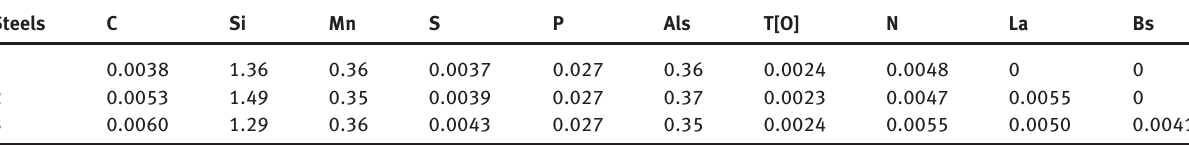
Table 1: Chemical compositions of all the tested steels (wt.%)